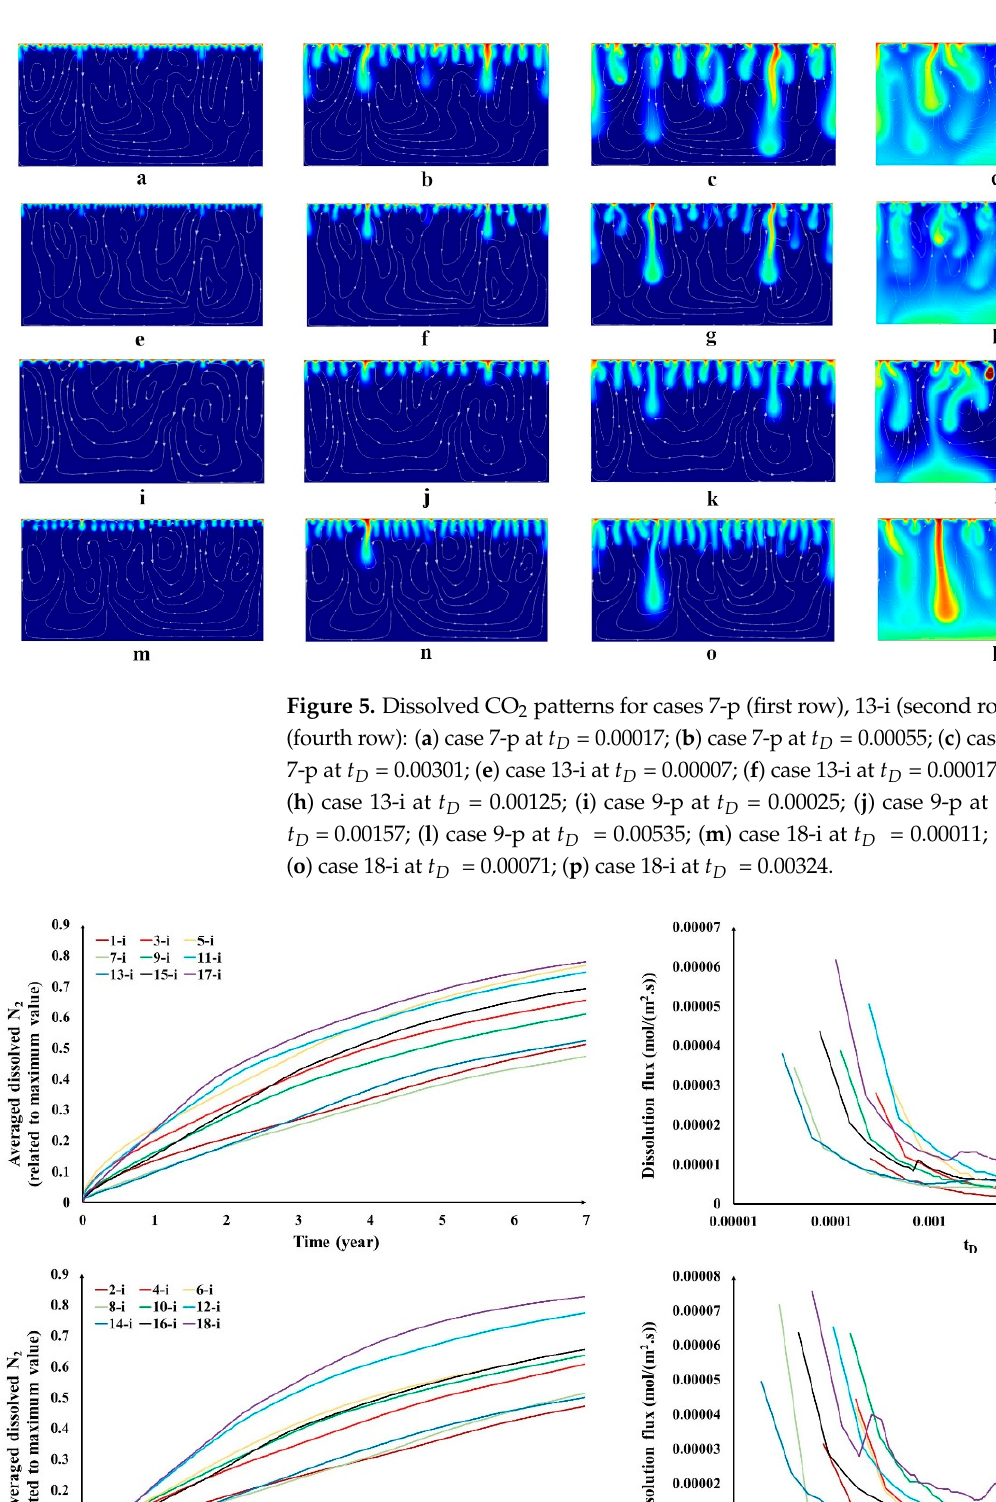
Figure 4. The averaged dissolved CO 2 and dissolution flux for pure and impure cases classified based on temperature. Legends for left- and right-hand subplots are same.